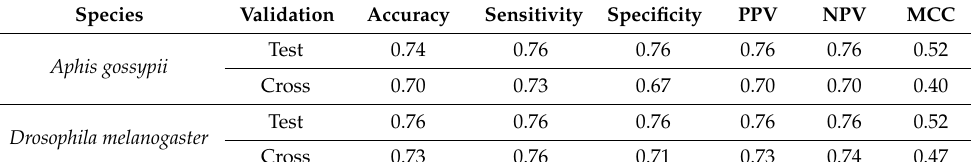
Table 2. Performance summary presenting the results obtained for all random forest models.